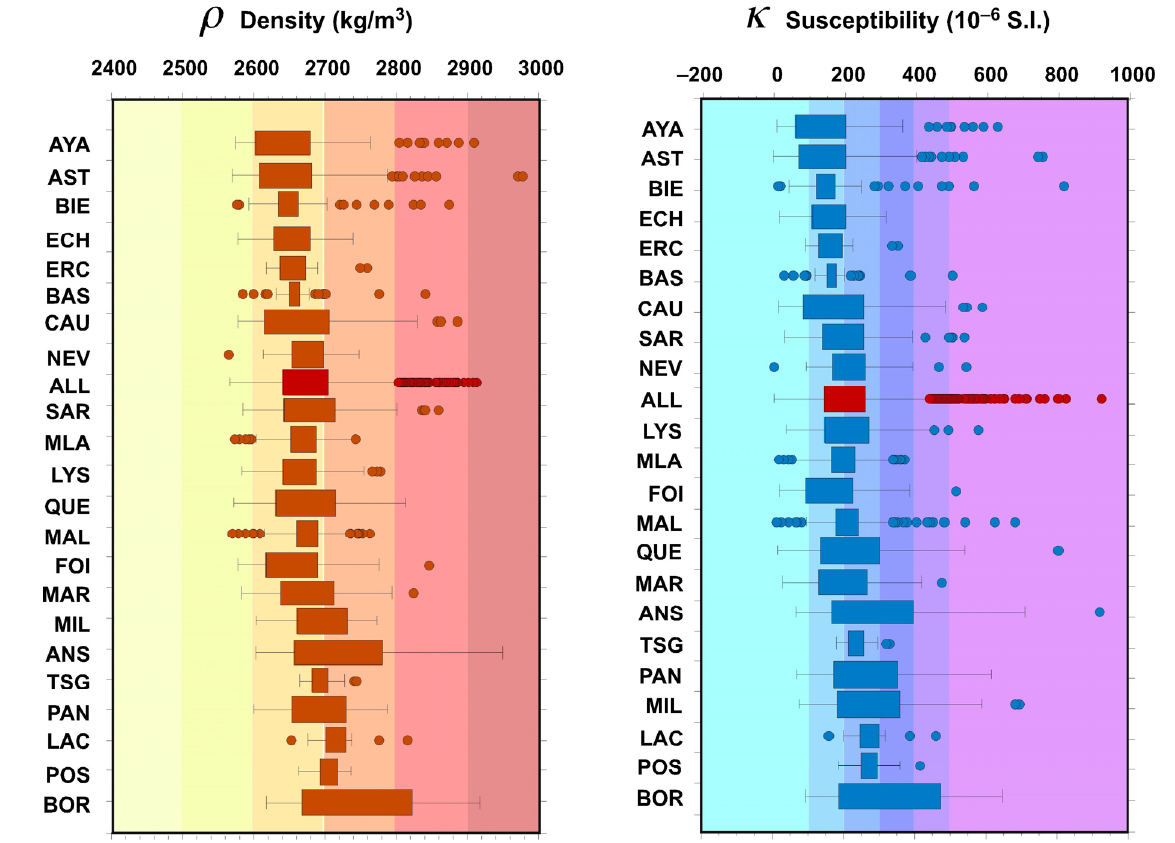
Figure 14. Individual box-plots of density and magnetic susceptibility (raw data) after the conversion of susceptibility into density in the Pyrenean granites (from the compilation by Porquet et al. [44]. The granites are sorted by increasing values of the density and susceptibility means. Ansignan (ANS) Aston (AST), Aya (AYA), Bassies (BAS), Bielsa (BIE), Borderes (BOR), Cauterets (CAU), Eaux Chaudes (ECH), Erce (ERC), Foix (FOI), Lacourt (LAC), Lys (LYS), Maladeta (MAL), Marimanha (MAR), Millares (MIL), Mont Luis-Andorra (MLA), Neouville (NEV), Panticosa (PAN), Posets (POS), Querigut (QUE), StArnac (SAR), Trois (TSG). All plutons together (ALL in red).